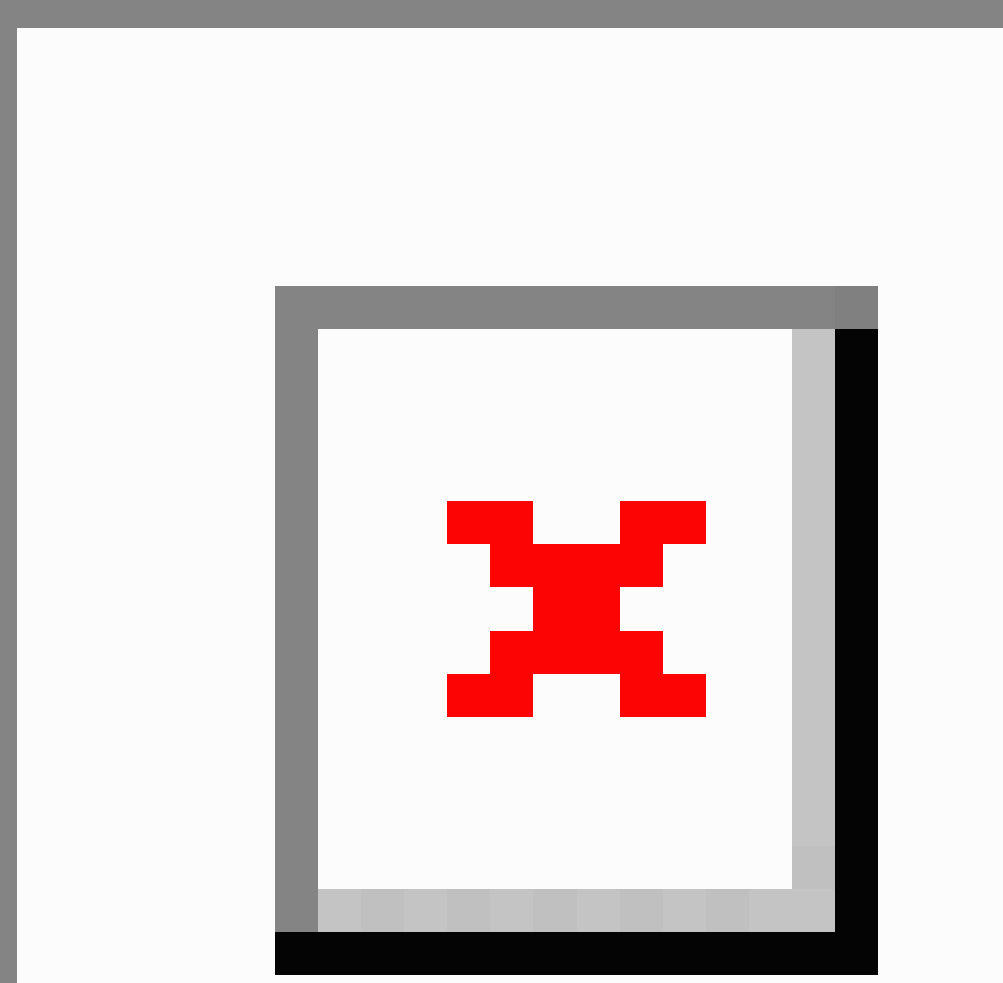
Lalloo et alJMIR MHEALTH AND